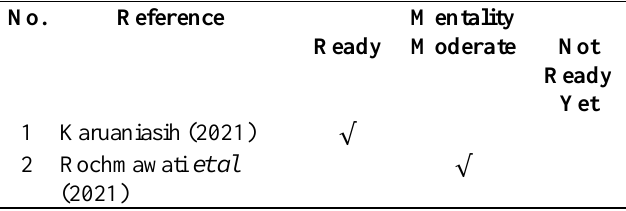
TABLE 14 | Mentality of Online Learning